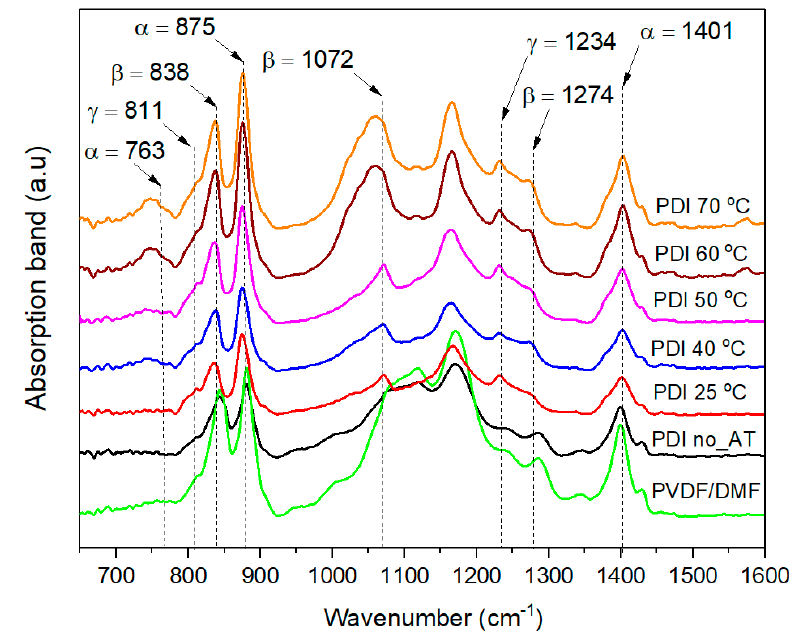
Figure 3. FTIR spectra without / with ionic liquid (IL) and annealing treatment at di ff erent temperatures.